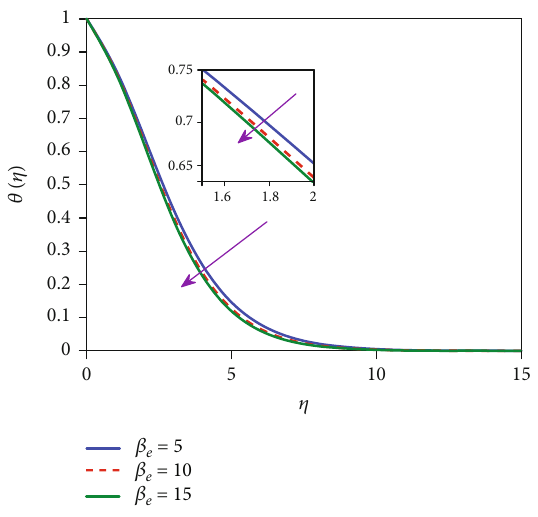
Figure 11: E ff ect of β